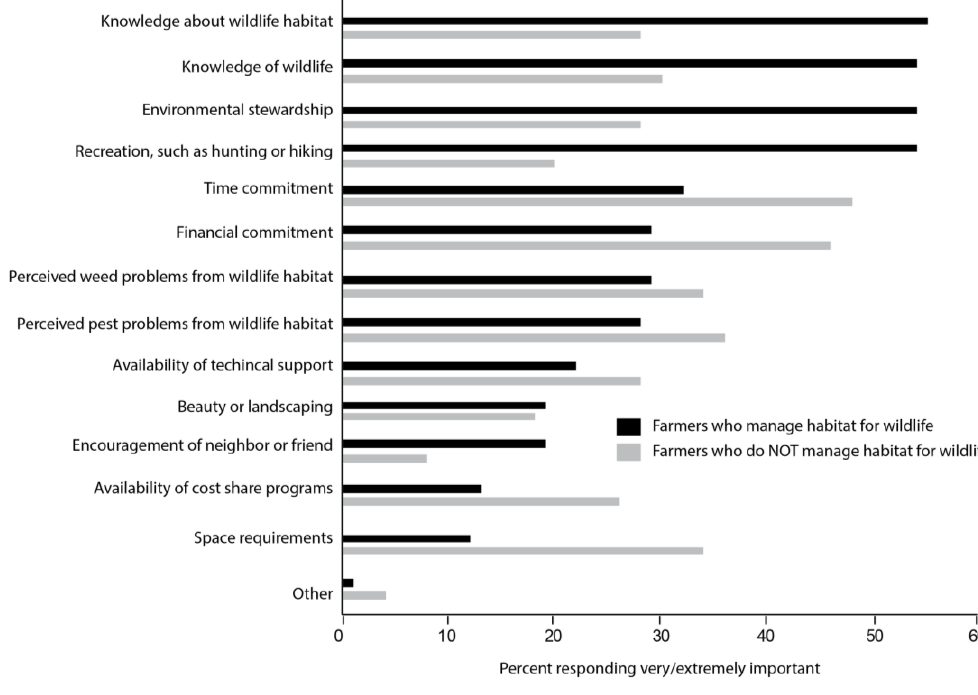
Figure 2. Percent of growers responding “very” or “extremely” to how important each factor is in their decision whether or not to manage habitat for wildlife (Q32).